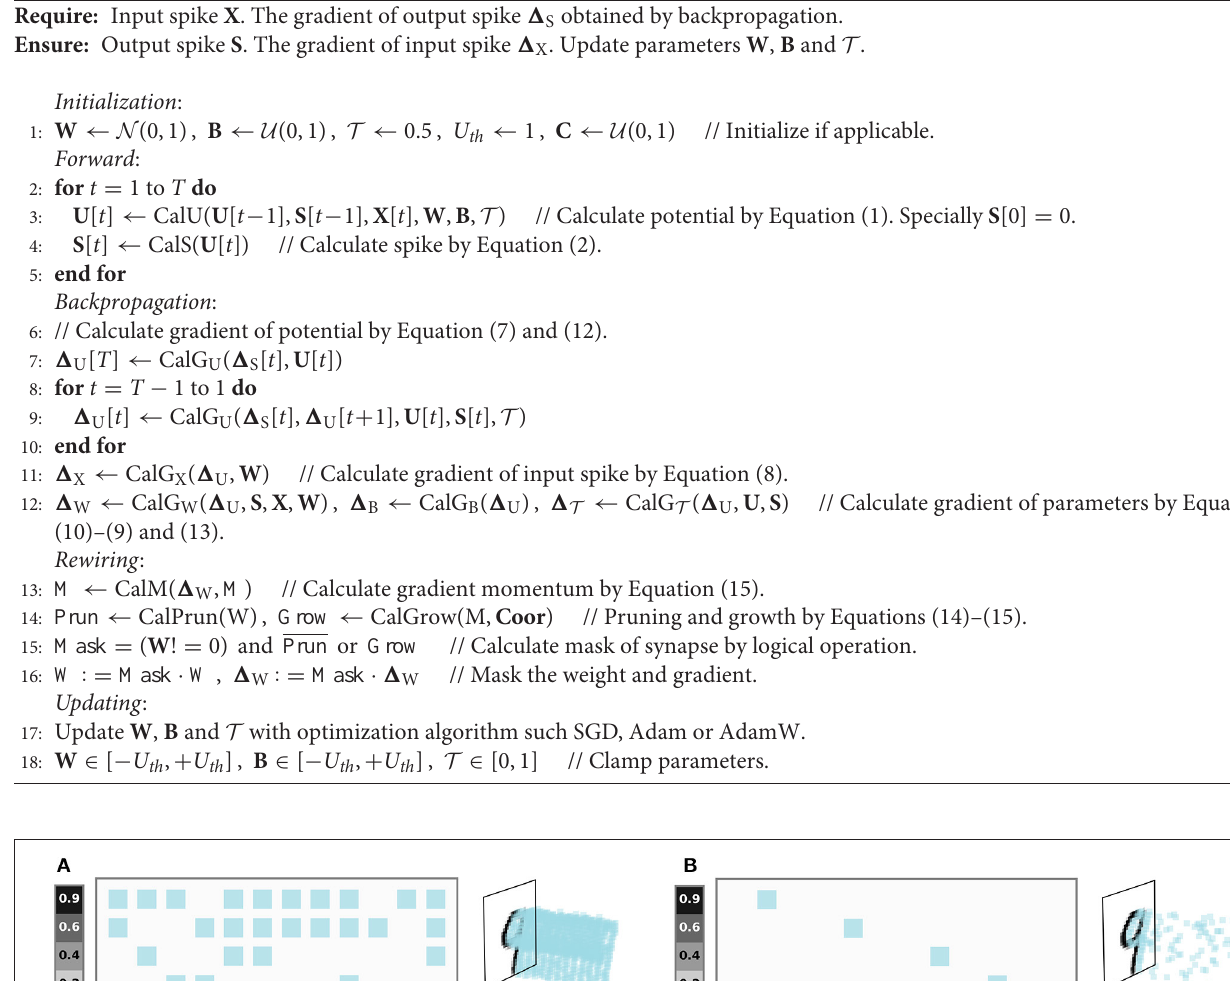
Algorithm 1: The BPSR implementation of layer L n .